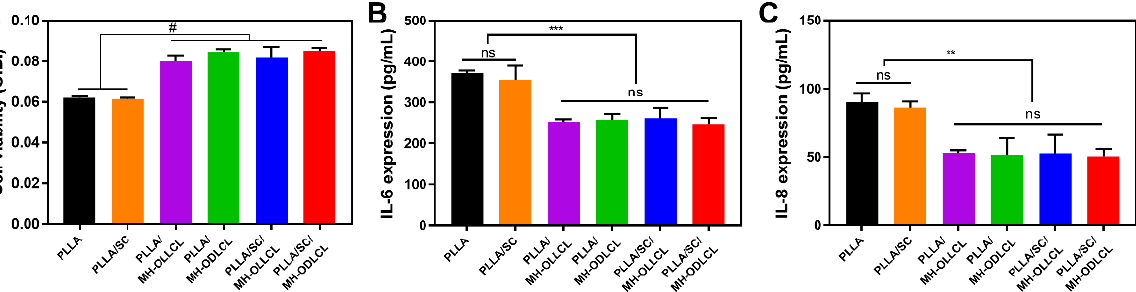
Figure 8. In vitro biocompatibility test of the PLLA and PLLA/MH, PLLA/SC, PLLA/MH–OLLCL, PLLA/MH–ODLCL, PLLA/SC/MH–OLLCL, and PLLA/SC/MH–ODLCL composites. ( A ) HCAECs cell viability with the degradation product of the PLLA composites treatment for 24 h. The expres- sions of ( B ) IL − 6 and ( C ) IL − 8 in HCAECs after 24 h, as determined by ELISA ( ** p < 0.01 , *** p < 0.001 , # p < 0.0001).